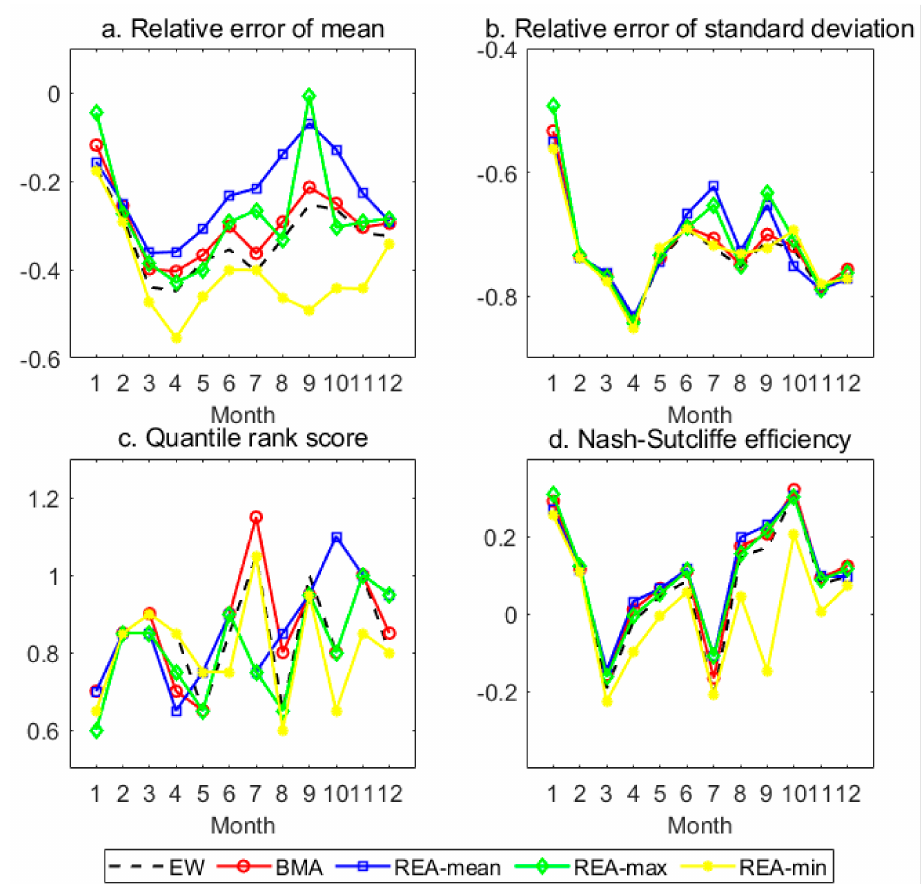
Figure 12. Performance of multi-model averaging of the six model combinations in the baseline period. Simple equal-weight averaging, Bayesian Model Averaging, Reliability Ensemble Averaging that optimizes the simulations of mean, maximum, and minimum monthly runoff are denoted by “EW”, “BMA”, “REA-mean”, “REA-max”, and “REA-min”,